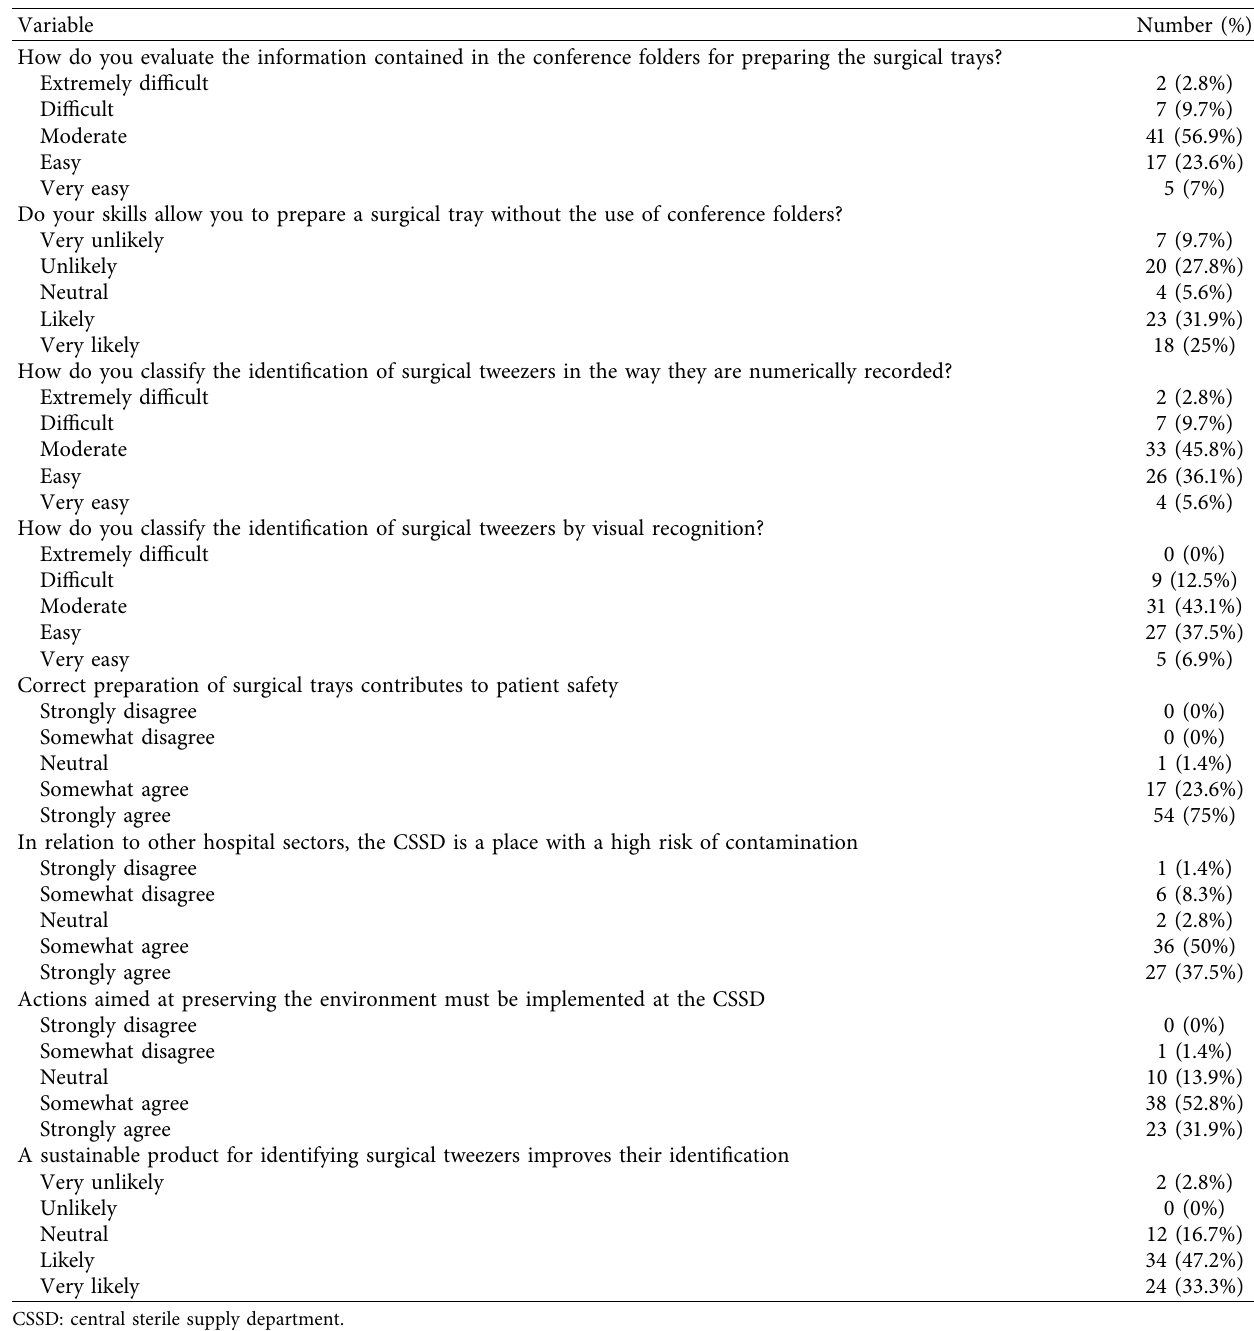
Table 4: Association between previous work at a central sterile supply department and professional ability.